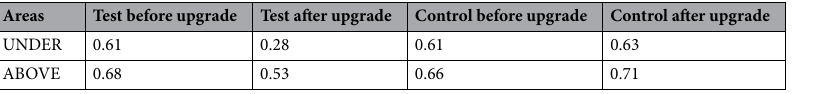
Table 3. Impact of UNDER